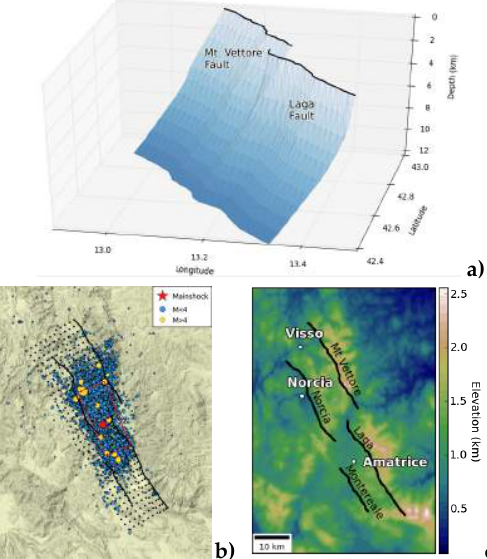
Figure 3: geometry of the fault source proposed for the 2016 earthquake sequence: a) 3D model implemented in OQ; b) surface projection of point sources (black dots) on earthquake locations, fault traces and rupture model; c) fault surface projection on the